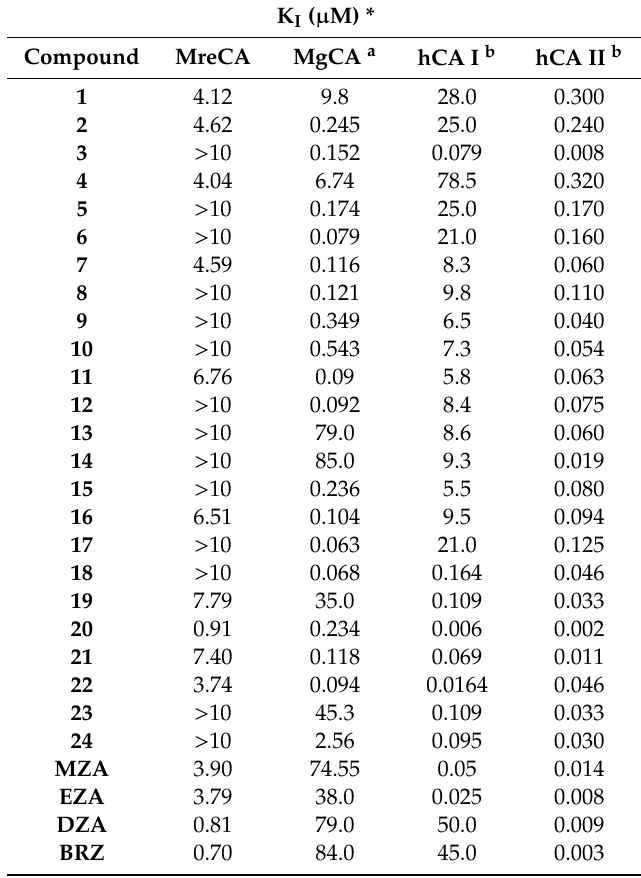
Table 3. Inhibition data of human isoenzymes (CA I and CA II) and fungal CAs (MreCA and MgCA) with the thirty-nine sulfonamides and one sulfamate by a stopped-flow CO 2 hydrase